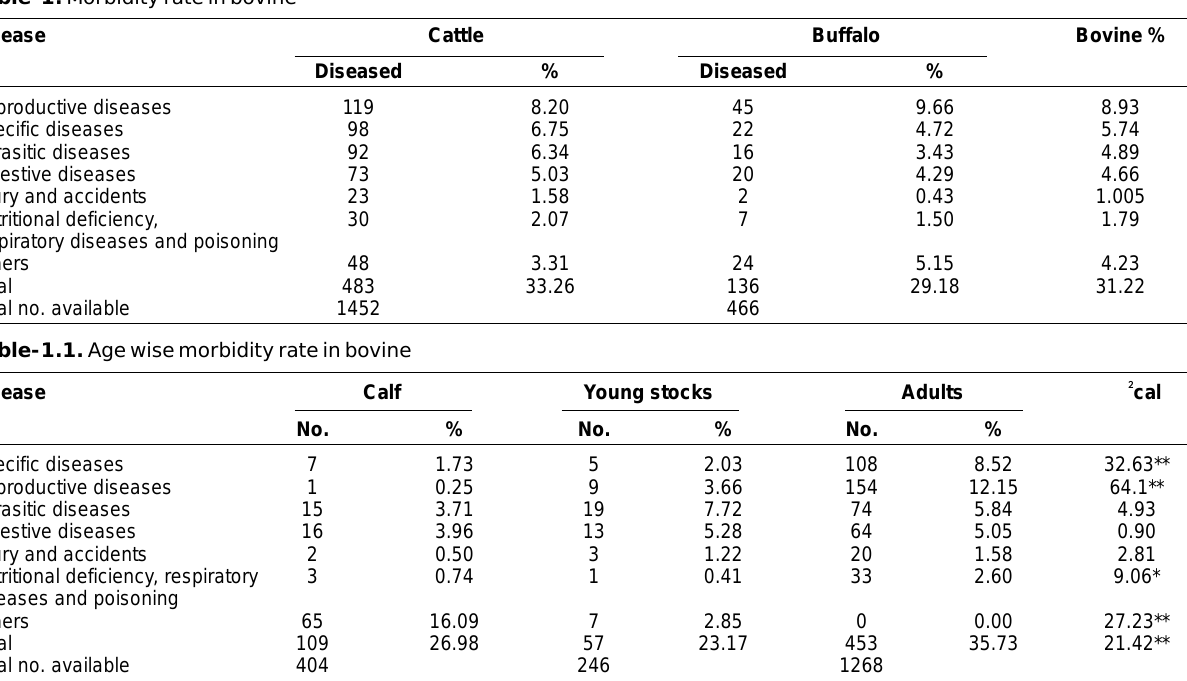
Table-1. Morbidity rate in bovine Disease